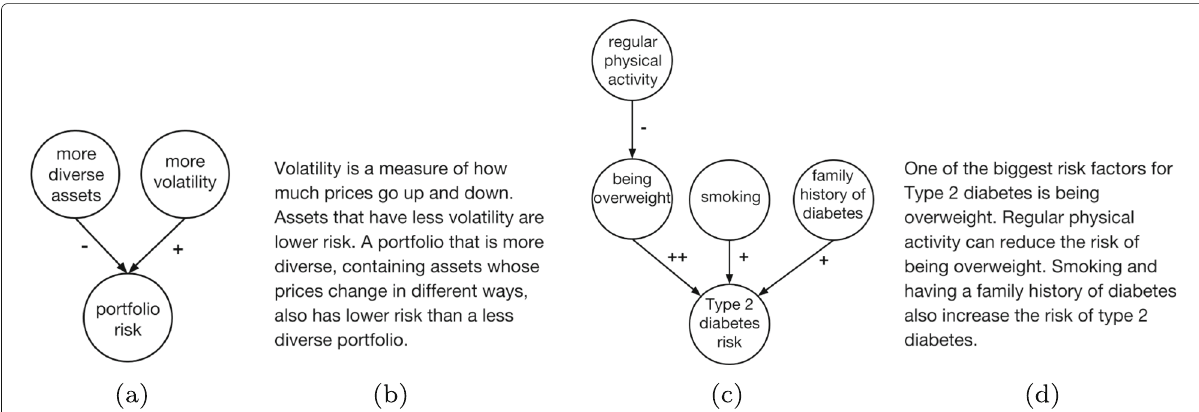
Fig. 5 Causal information for real-world questions in Experiment 4. Figures were scaled with nodes at the same size. a Finance diagram. b Finance text. c Diabetes diagram. d Diabetes text